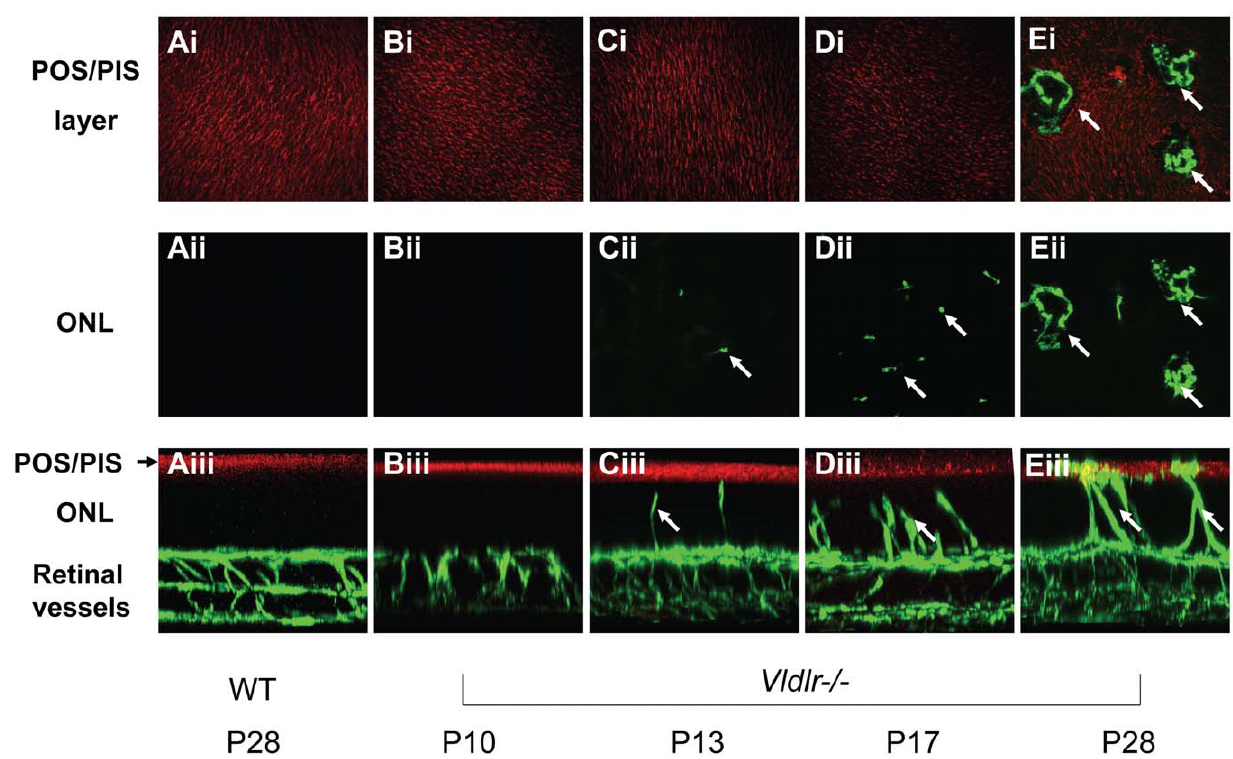
Figure 1. Origin of retinal vascular lesions in the Vldlr-/- eye. Confocal microscopy was used to generate ‘‘optical sections’’ through whole mounts of retinas following the vascular filling assay to label all retinal blood vessels (green). The cone sheaths were labeled red with peanut agglutinin to visualize the outer retina. Stacks of the optical sections were assembled to show either the photoreceptor cell outer and inner segment region (POS and PIS; A1 through E1 ) or the outer nuclear layer (ONL; A2 through E2 ). The entire stack of sections through the retina was assembled for 3D reconstruction which was then rotated 90 u for a cross-sectional view of the retinas at different developmental ages ( A3 through E3 ). See text for further